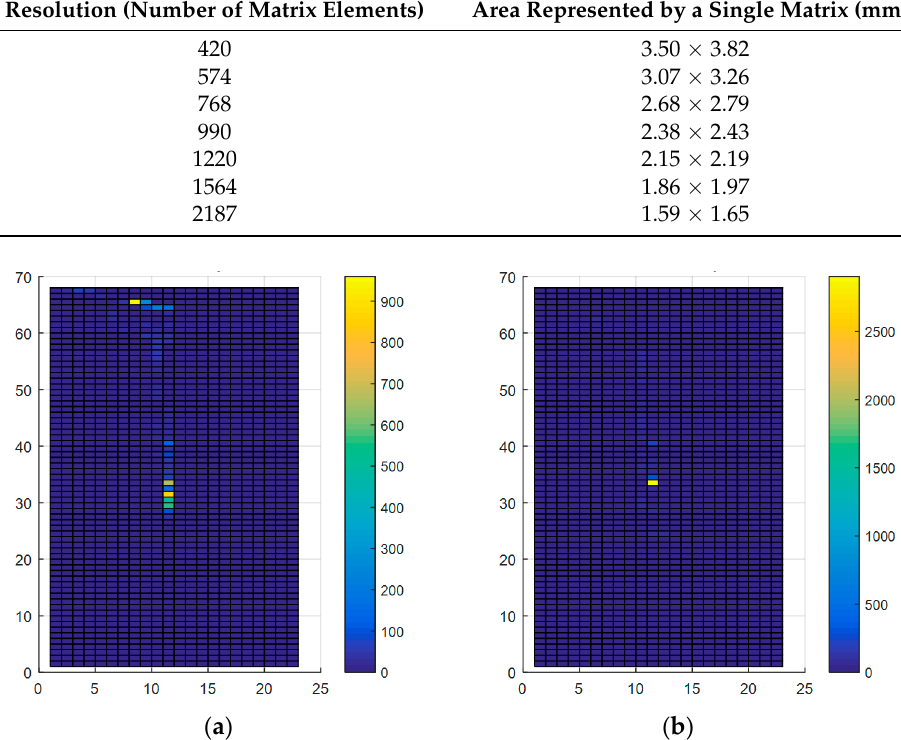
Table 3. List of the tested resolutions and their correspondent superficies.